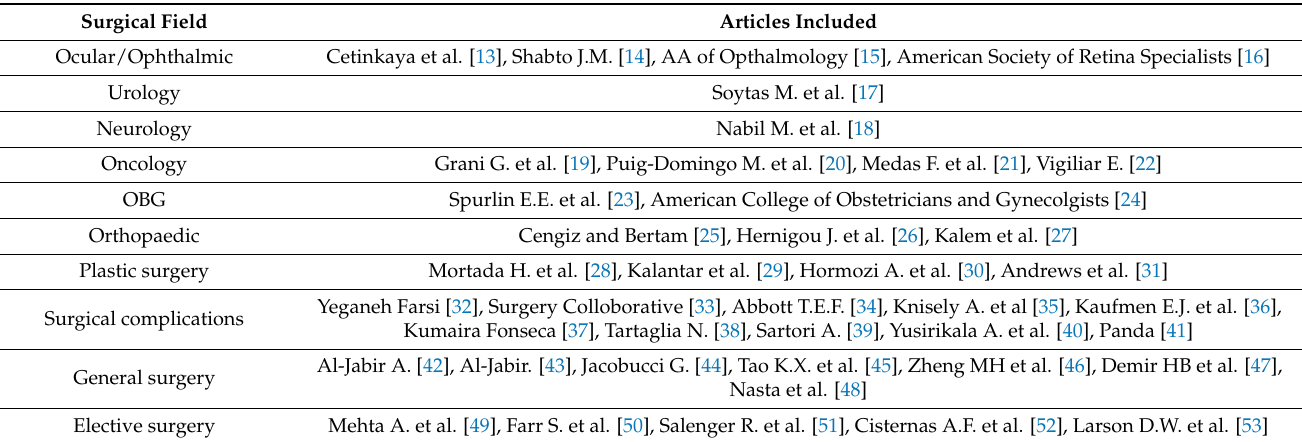
Table 1. List of the articles